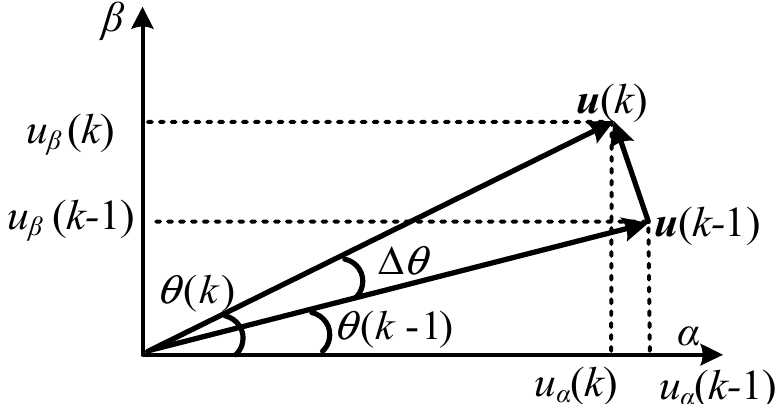
Figure 3. Bode diagram of SRF-PLL with different k p . In this paper, we propose a new method for accurate and fast frequency measurement. the voltage vector. Figure 4 shows a rotation vector diagram of grid side voltage at two adjacent sampling times measured by Clark transformation.